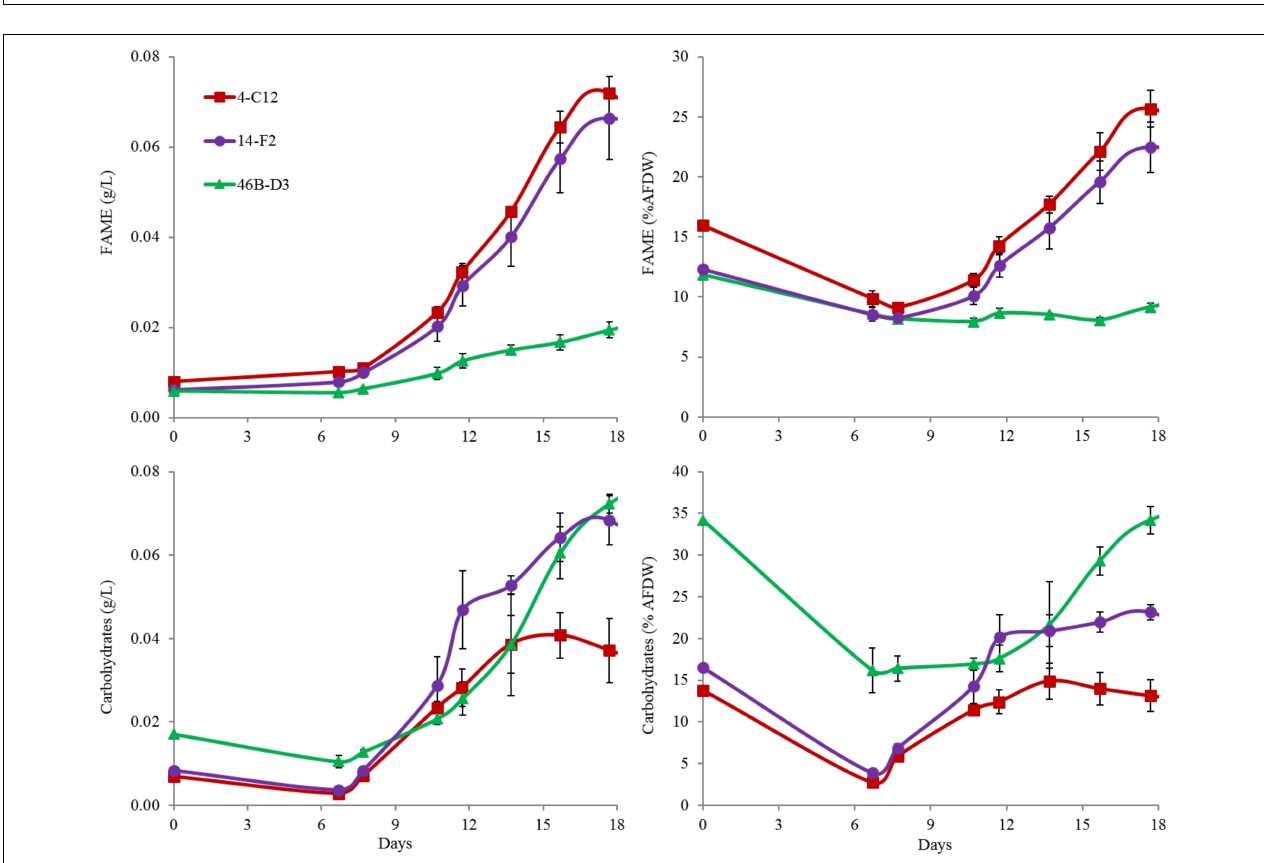
FIGURE 1 | (Left) Ash-Free Dry Weight accumulation and (right) areal productivities for strains cultivated outdoors during the winter month of February 2016 (1st–19th). Maximum productivity is calculated from the steepest portion of growth curve, while harvest-yield productivity measures all biomass accumulated up to day 18. Average and standard deviation error bars are from 3 biological replicates.